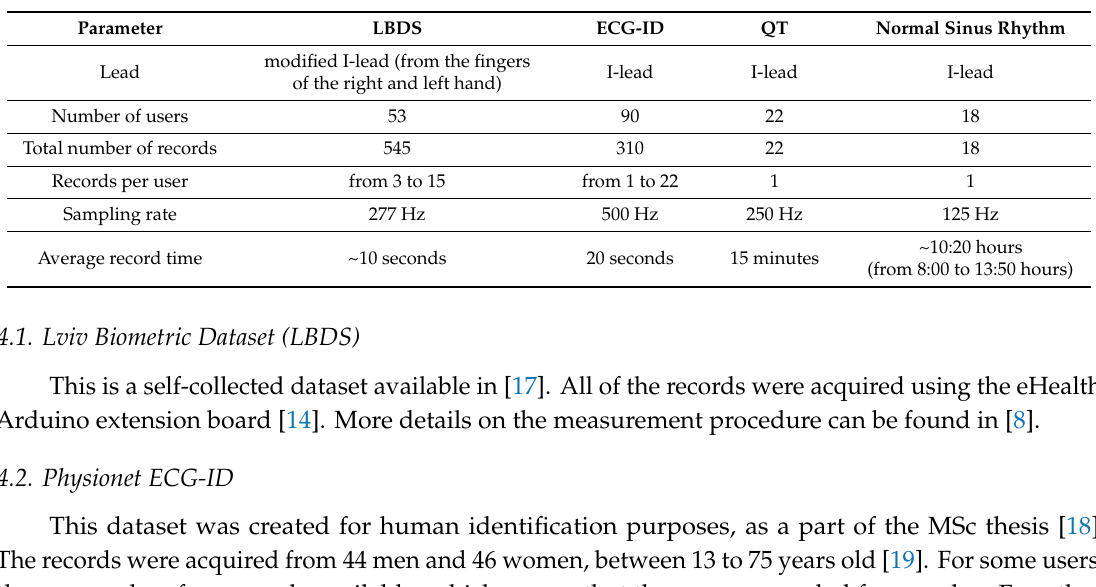
Table 1. Basic parameters of the ECG